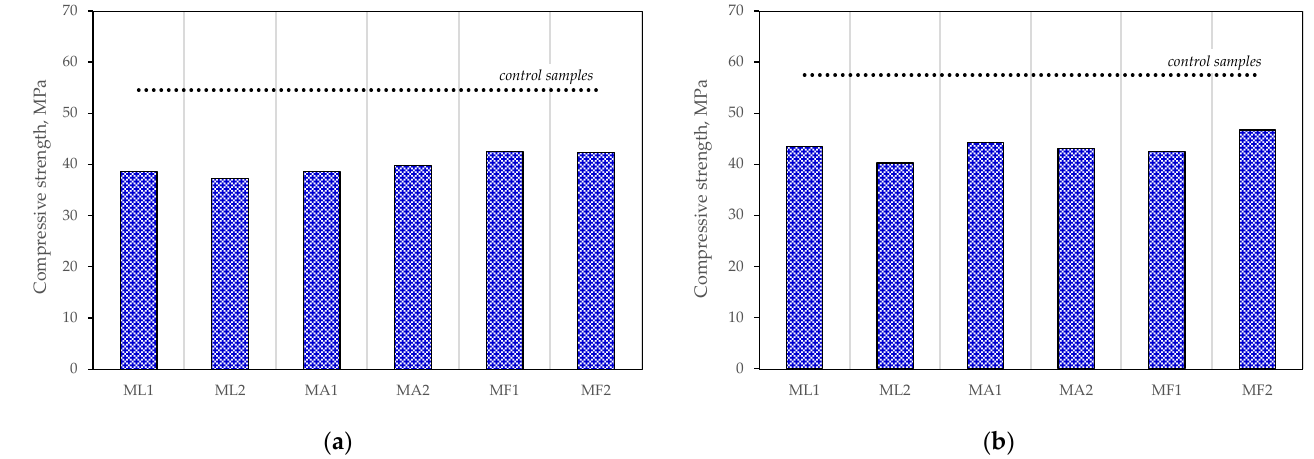
Figure 7. Results of the mechanical properties tests of mortars No 2: ( a ) after 28 days; ( b ) after 90 days.